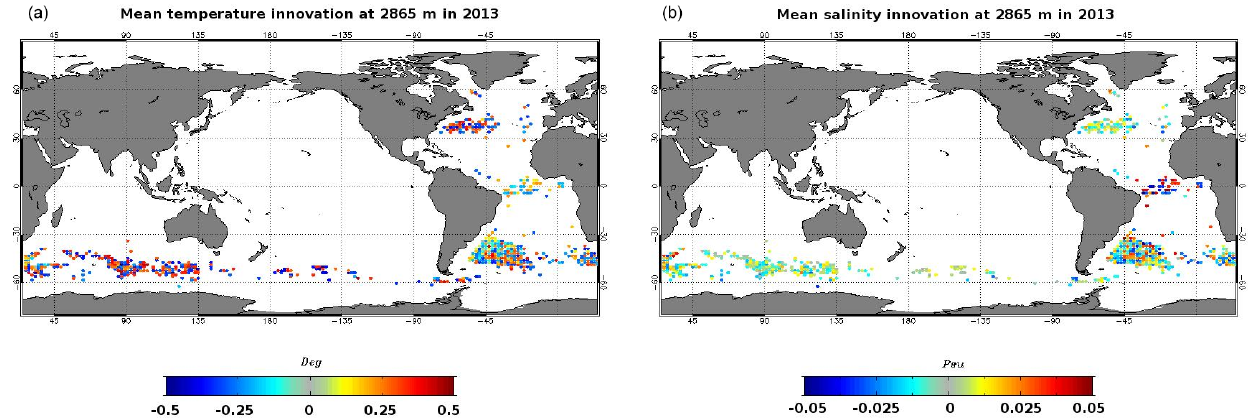
Figure 10. Mean temperature ( a , units in ◦ C) and salinity ( b , units in psu) innovations in 2013 at 2865m for the system